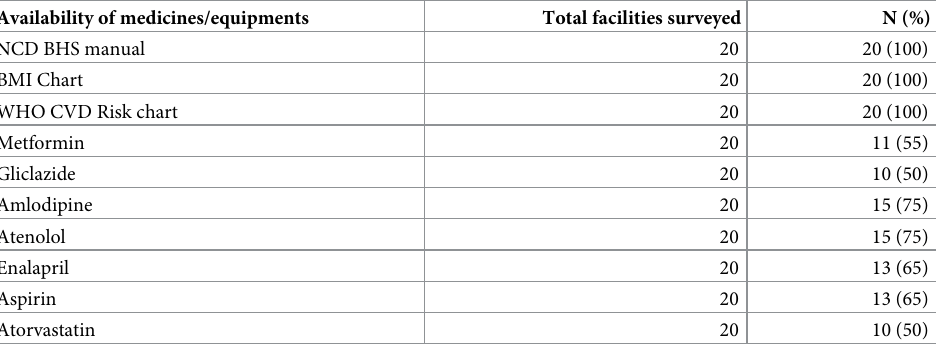
Table 6. Availability of medicines and other supplies at 20 PEN implementing facilities in Myanmar in